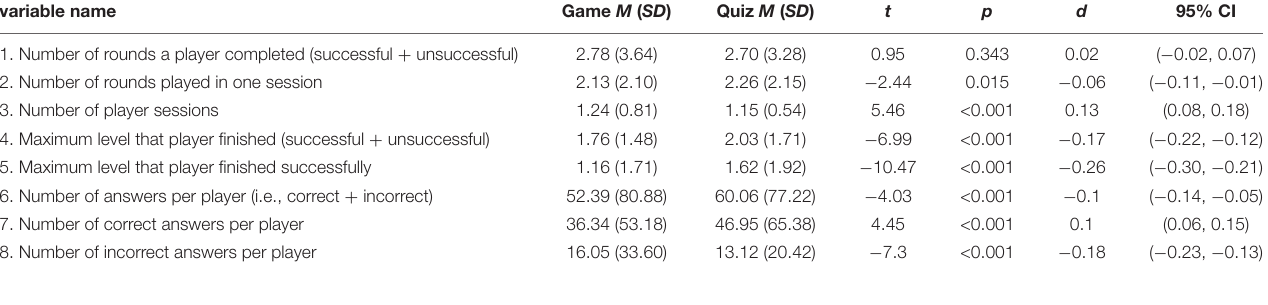
TABLE 1 | Selected game/quiz parameters and their comparison for players who completed at least one round. We report t - and p - values from between-subject t -tests.